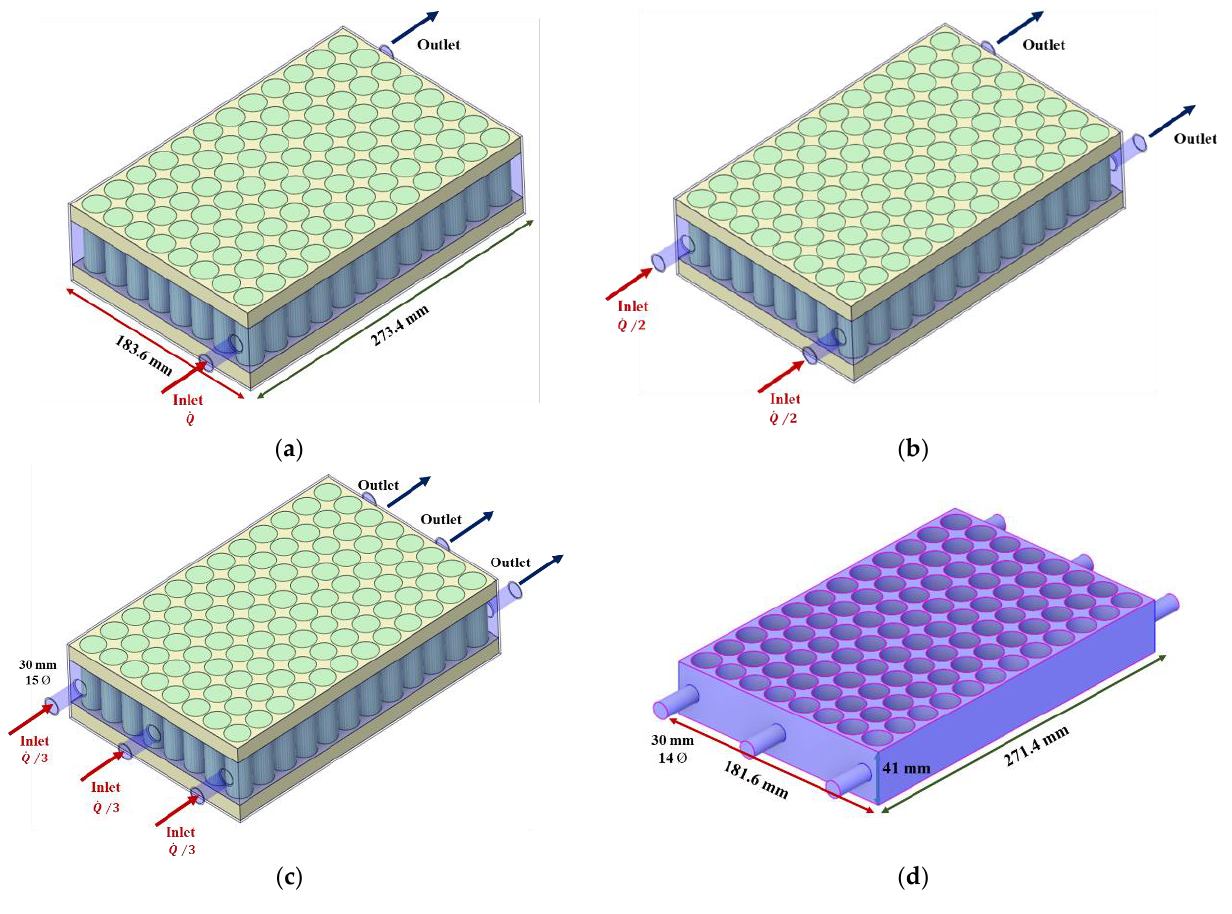
Table 1. Thermo-physical properties of the battery module [33].